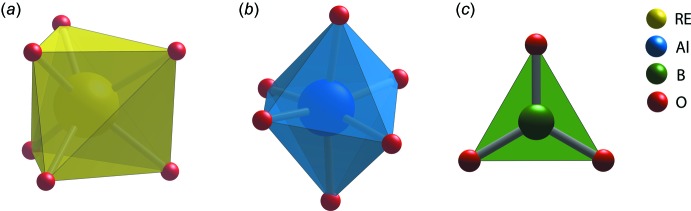
Coordination of oxygen atoms around (a) rare-earth, (b) aluminum, and (c) boron atoms shown as polyhedra.